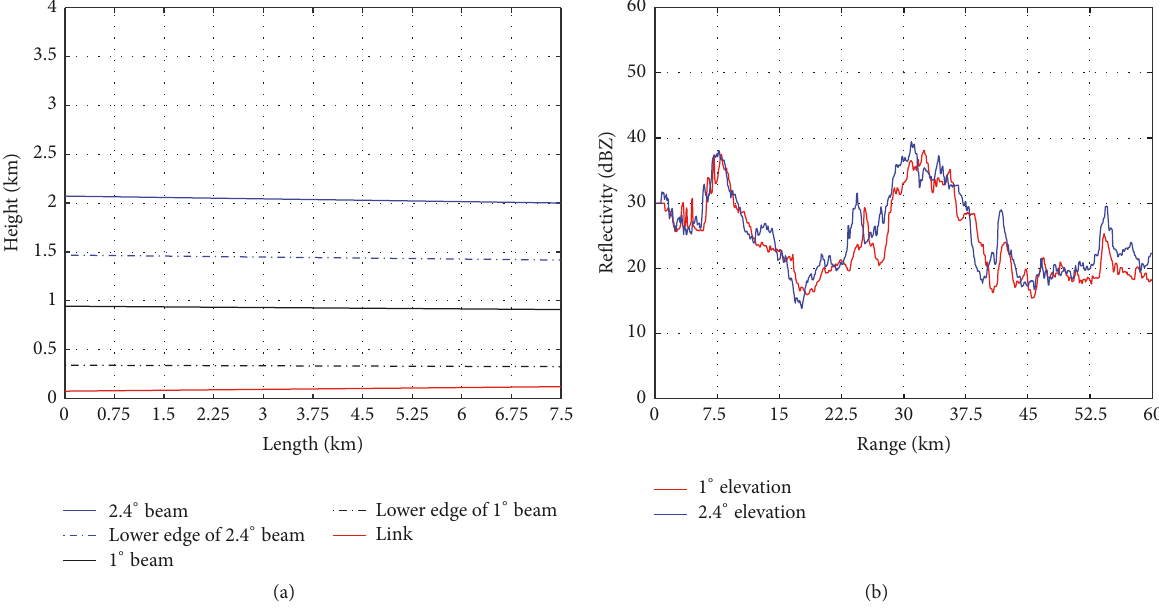
Figure 19: Comparisons of (a) heights of the link and radar beams and (b) range profiles of reflectivity of the 1 ∘ and 2.4 ∘ elevation at azimuth 236 ∘ in Figure